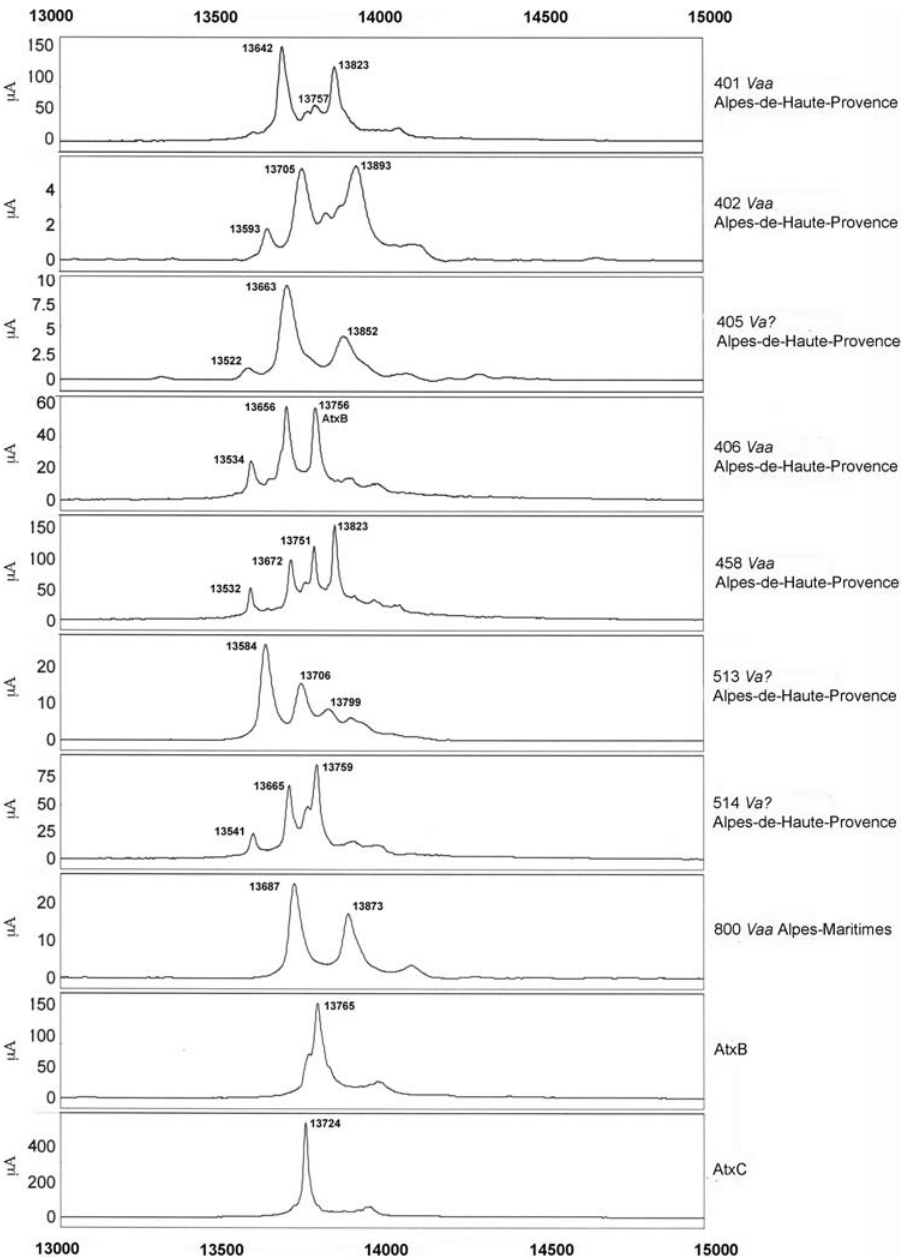
Figure 10. SELDI profiles of venoms from the south-east of France. Peak molecular weights consistent with those of PLA 2 s are indicated on the